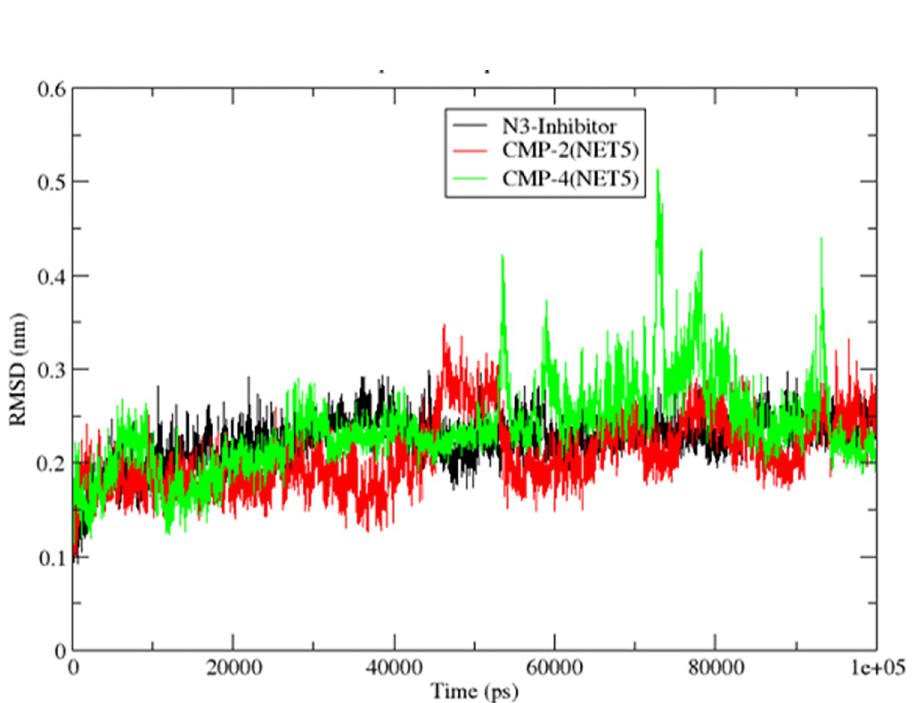
Fig 6. The RMSD of the protein molecule calculated over 100 ns MD simulation trajectories for the selected hits CMP2 (NET5) and CMP4 (NET5) and the reference ligand N3.